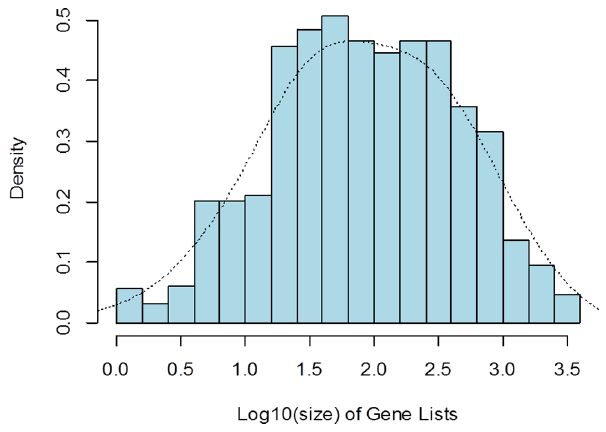
Figure 1. Histogram of log10 scale of size of gene